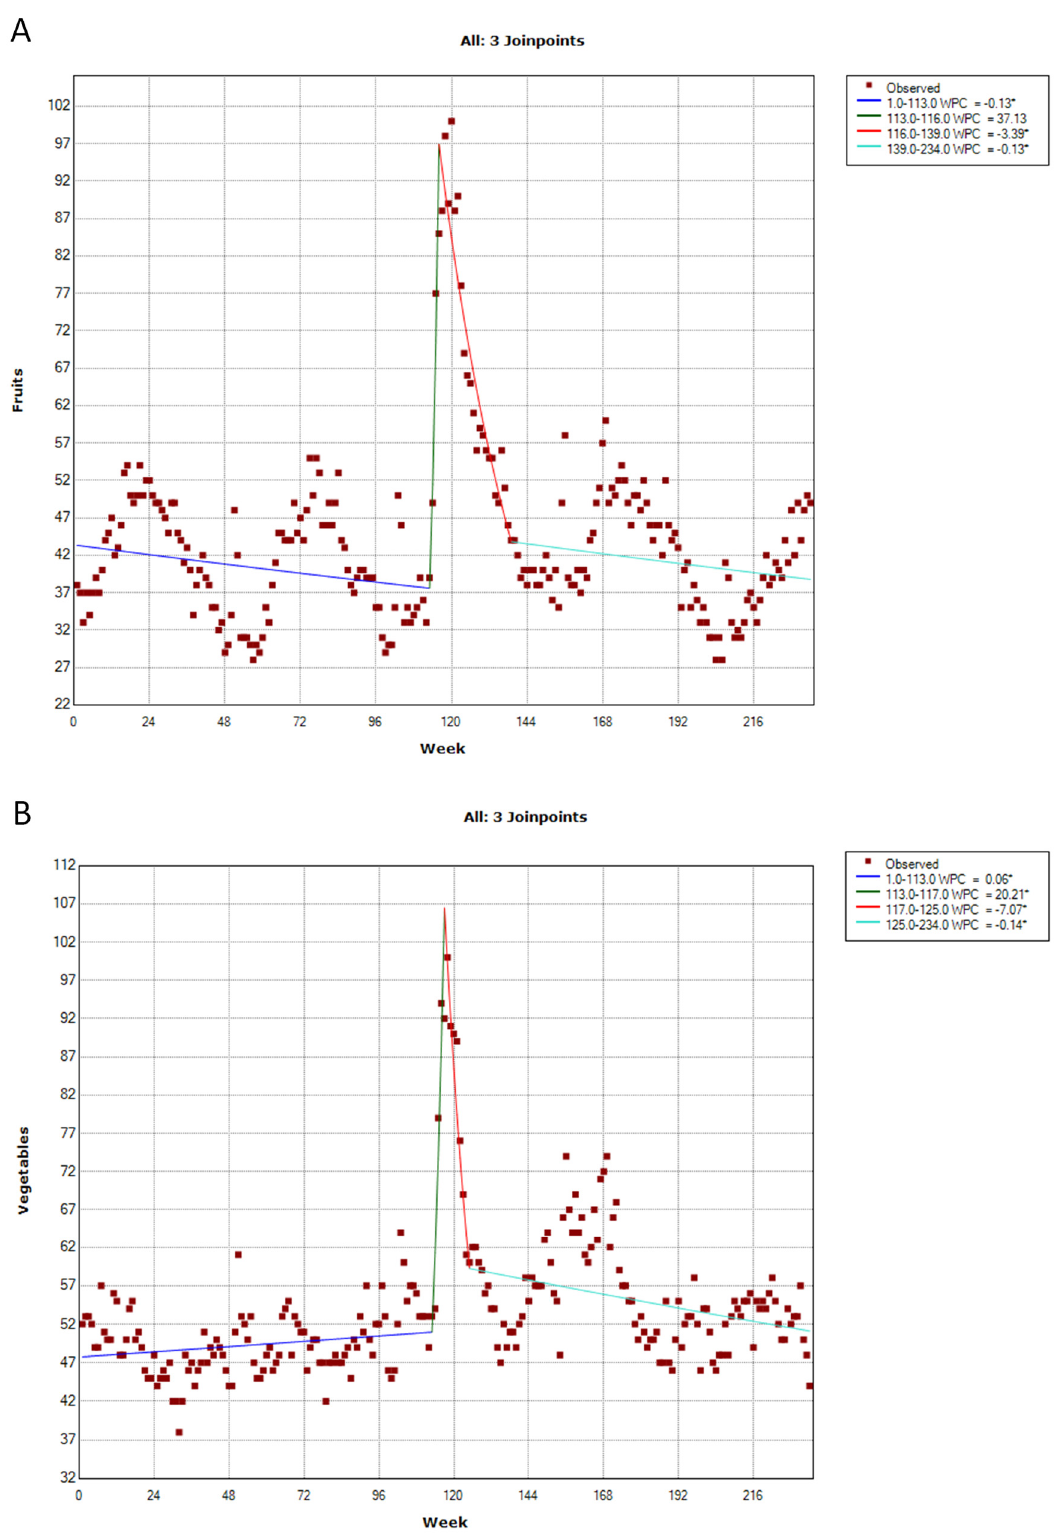
Figure 2. Joinpoint analysis of public interest in fruit ( A ) and vegetables ( B ). * p -value < 0.05.